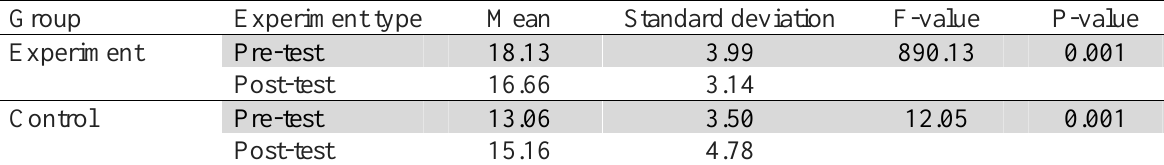
The results of testing FLE in terms of women’s capabilities for financial management Group